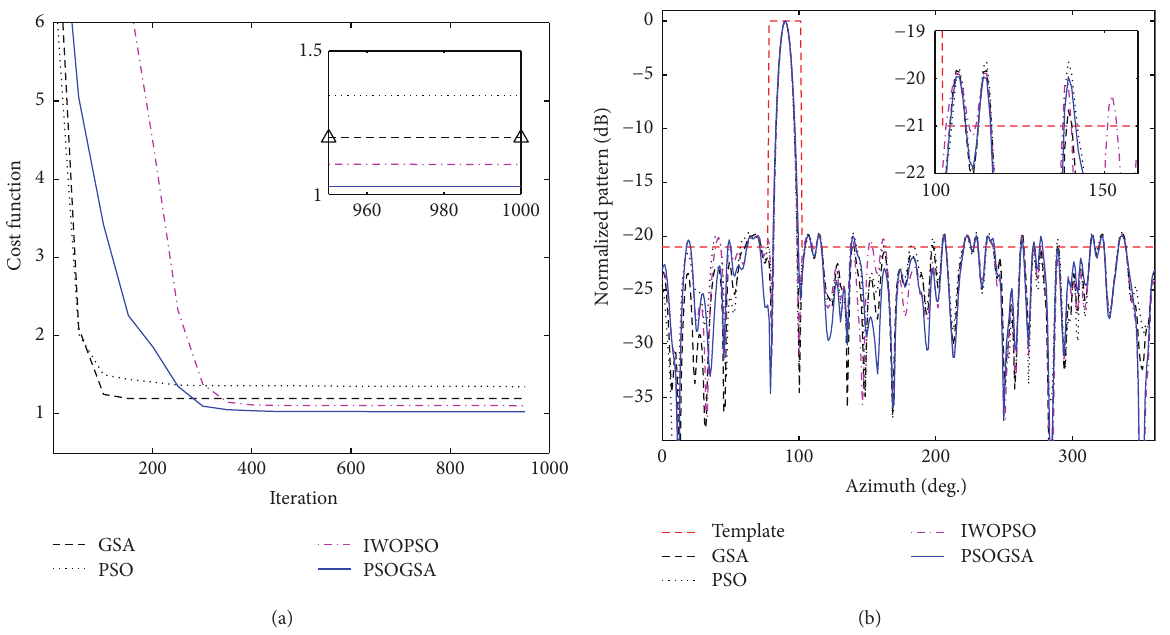
Figure 9: (a) Cost function versus iteration times with coupled pattern. (b) Radiation pattern for the half-circular array with coupled pattern.